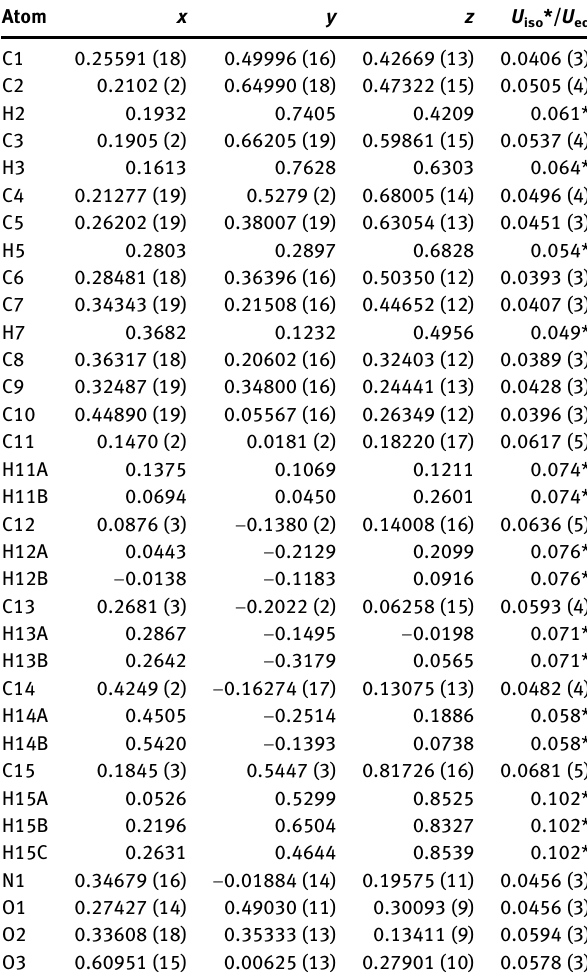
Table  : Fractional atomic coordinates and isotropic or equivalent isotropic displacement parameters (Å 